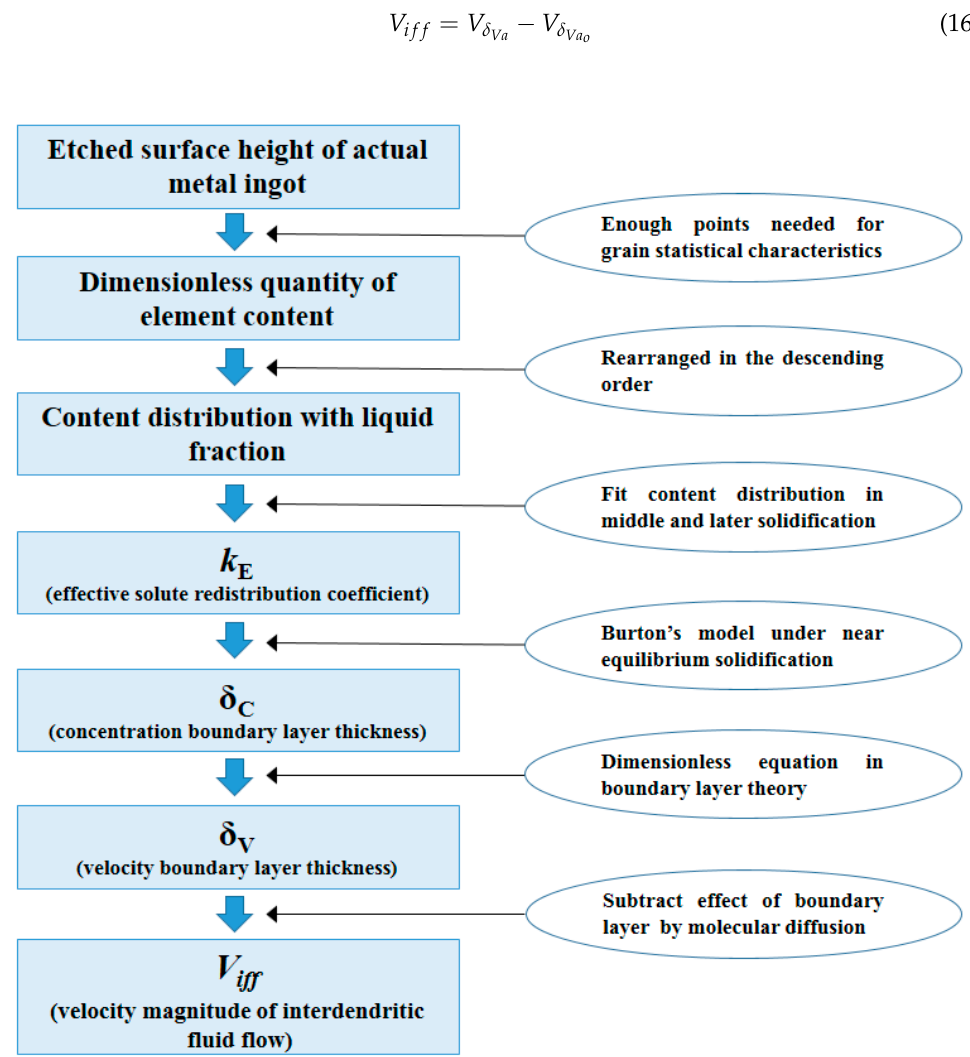
Figure 12. Calculation flowchart for magnitude of interdendritic fluid flow velocity V if f using the etched surface height of the actual metal ingot.